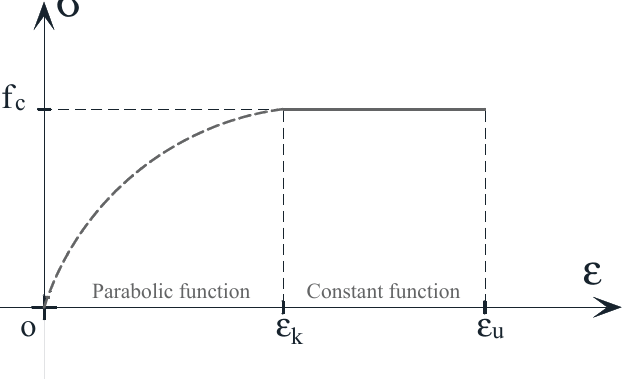
Figure 2. Stress–strain relationships of the masonry.